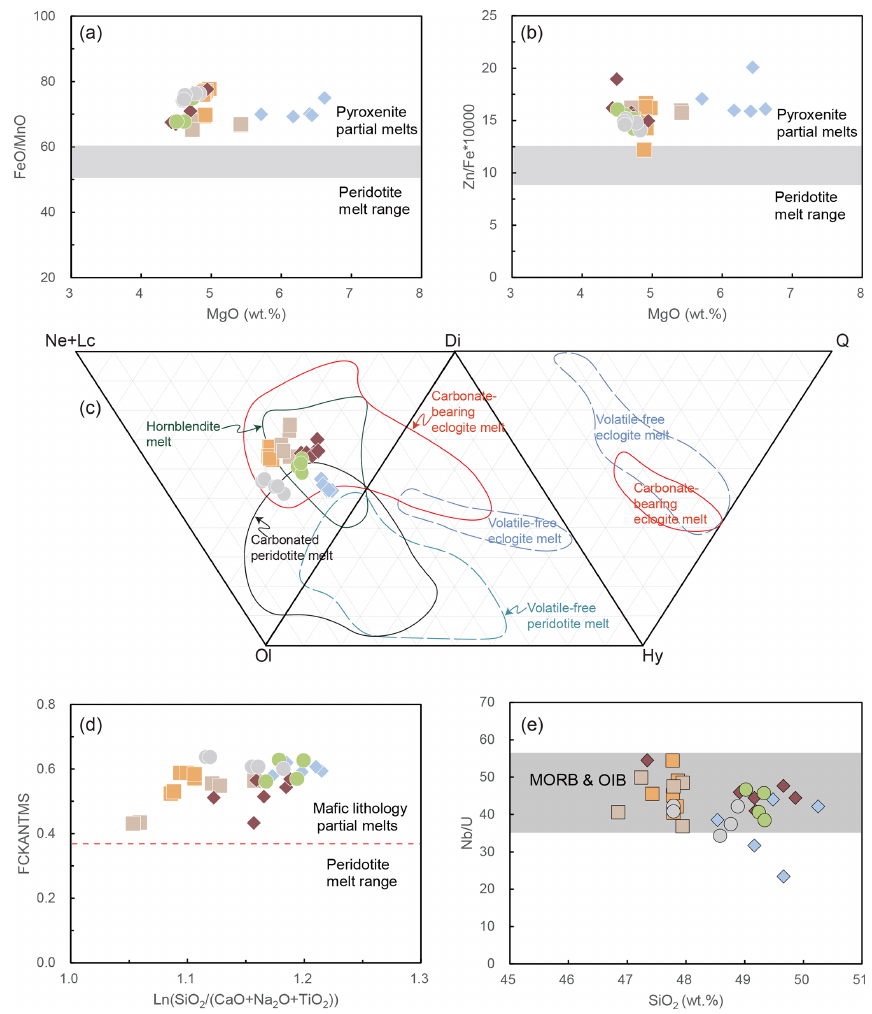
Figure 11. Geochemical compositional indicators of mantle source lithology and crustal contamination. (a) FeO / MnO and (b) Zn / Fe × 10000 vs. MgO; the boundary field between the peridotite melt range and pyroxenite melt are after Herzberg (2011) and Le Roux et al. (2010), respectively. (c) CIPW normalization plotted on Ne + Lc (nepheline + leucitite), Ol (olivine), Di (diopside), Hy (hypersthene), Q (quartz) and the fields for experimental melting data as outlined in Fig. 6. (d) FCKANTMS parameter vs. Ln(SiO 2 /( CaO + Na 2 O + TiO 2 ) ); the FCKANTMS parameter calculation and discrimination line for mafic lithology-derived melts are from Yang et al. (2019). (e) Nb / U vs. SiO 2 ; the shaded field for MORB (mid-ocean ridge basalt) and OIB is from Hofmann et al. (1986). Symbols and fields are the same as in Fig.